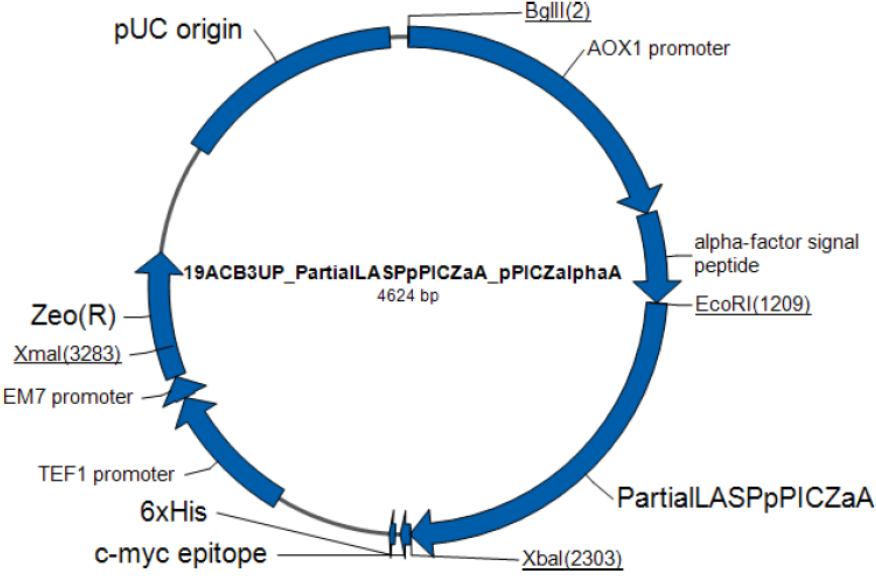
Figure 6. Plasmid map of pPICZ α A carrying the synthetic partial L ‐ asparaginase gene from P. sizovae . Transformation of competent E. coli cells with 1 ng of pPsASNase was performed by a chemical method using One Shot™ TOP10 Chemically Competent E. coli (Invitrogen Thermo Fisher Scientific) according to the manufacturer’s instructions. Transformation of